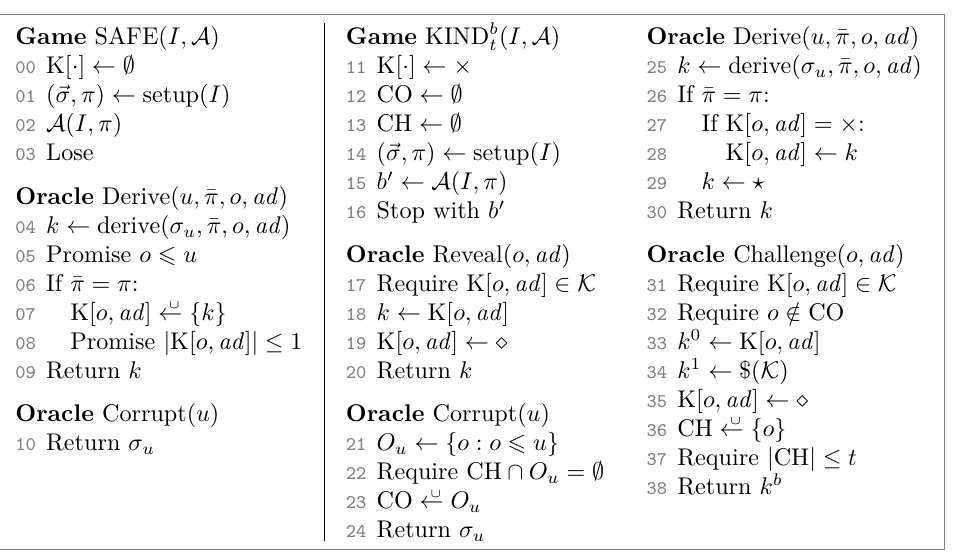
Figure 3: Games for KAS. For all values u, ¯ π, o, ad provided by the adversary we